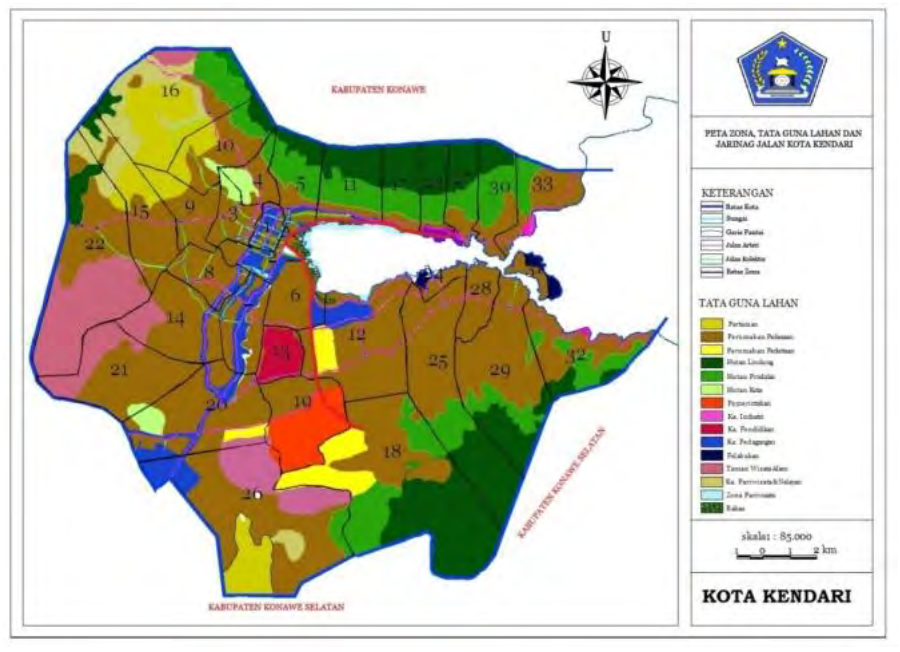
Figure 4. Map of Land Use